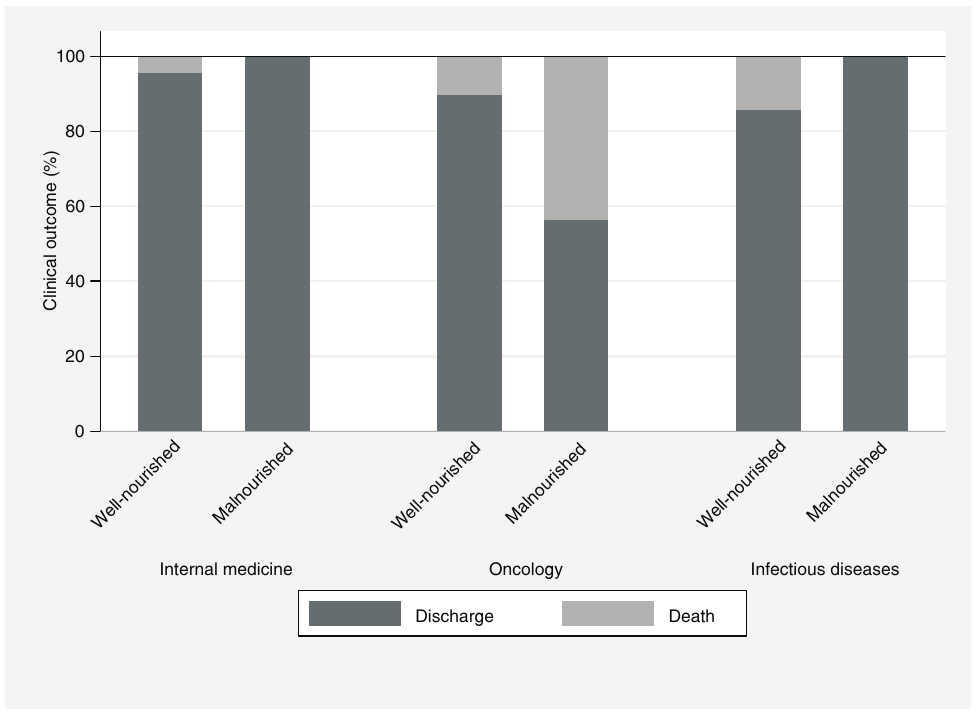
Figure 3. Clinical outcome as a function of nutritional status. Nutritional status was assessed by Subjective Global Assessment (SGA) within the first 48 h of hospitalization. SGA A = well-nourished; SGA B + SGA C = malnour - ished. Data are reported as percent of